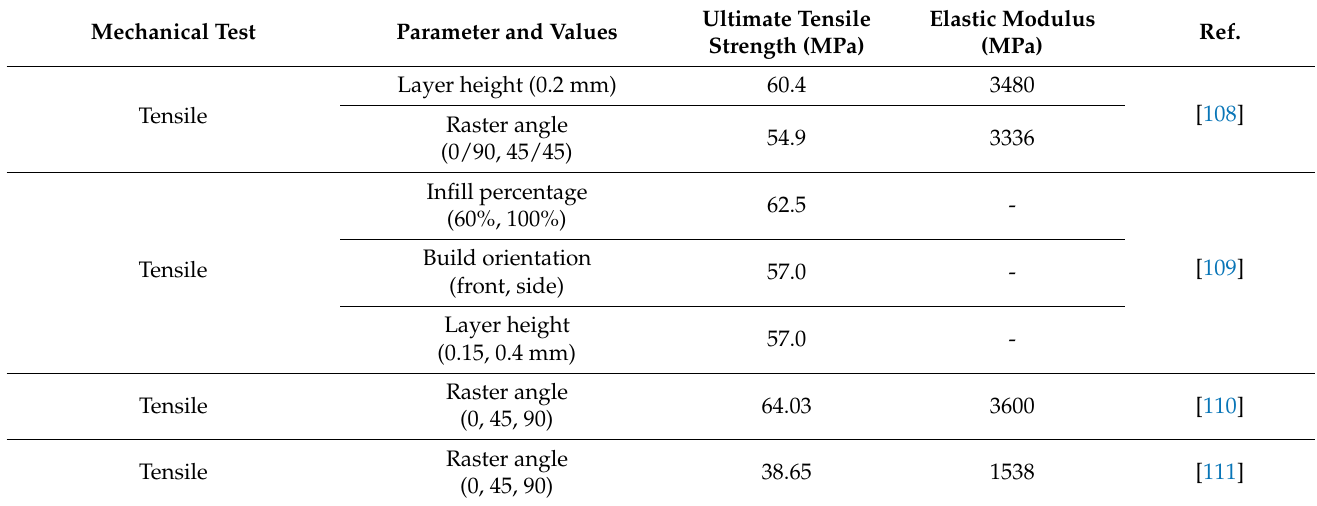
Table 4. Mechanical properties of pure